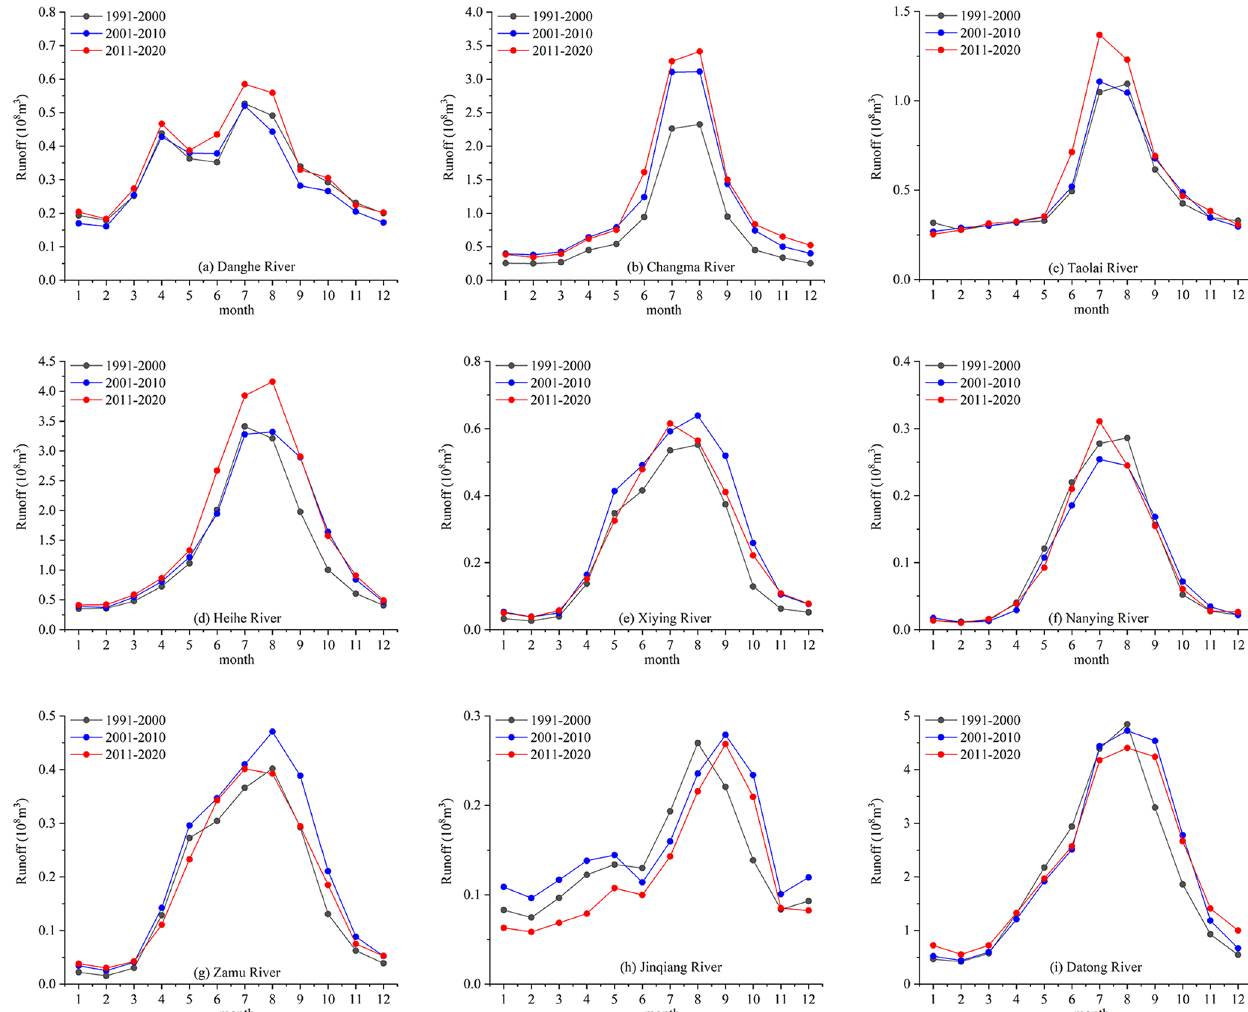
Figure 15. Seasonal variation of runoff after 1990 in the Hexi inland river system: (a) Danghe River, (b) Changmahe River, (c) Taolai River, (d) Heihe River, (e) Xiying River, (f) Nanying River, and (g) Zamu